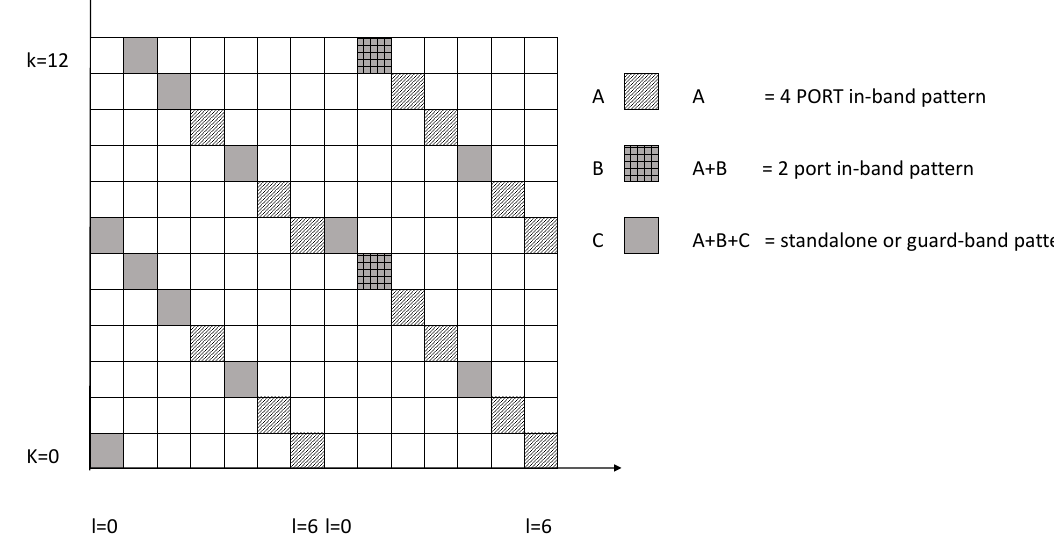
Figure 5. Narrowband positioning reference signal